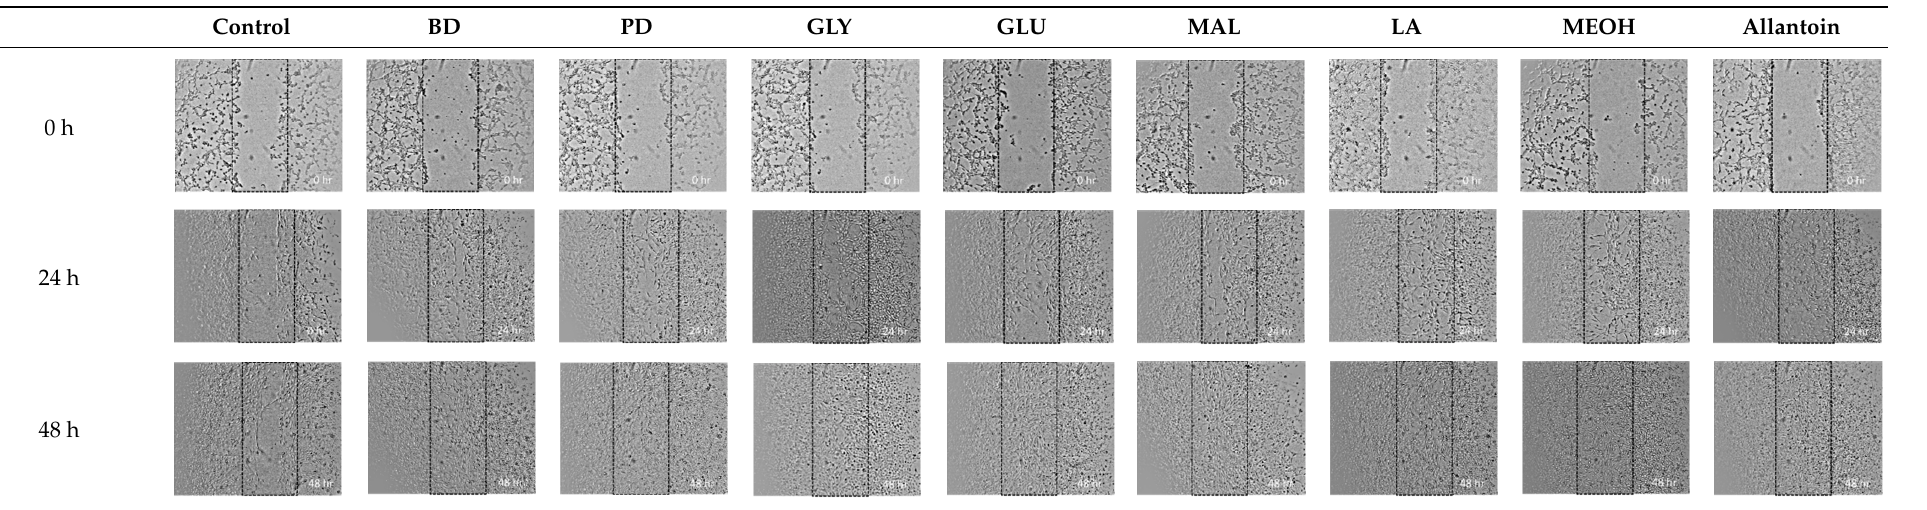
Table 3. Representative cell proliferation and migration activities in vitro scratch wound assay at 7.81 µ g mL − 1 .